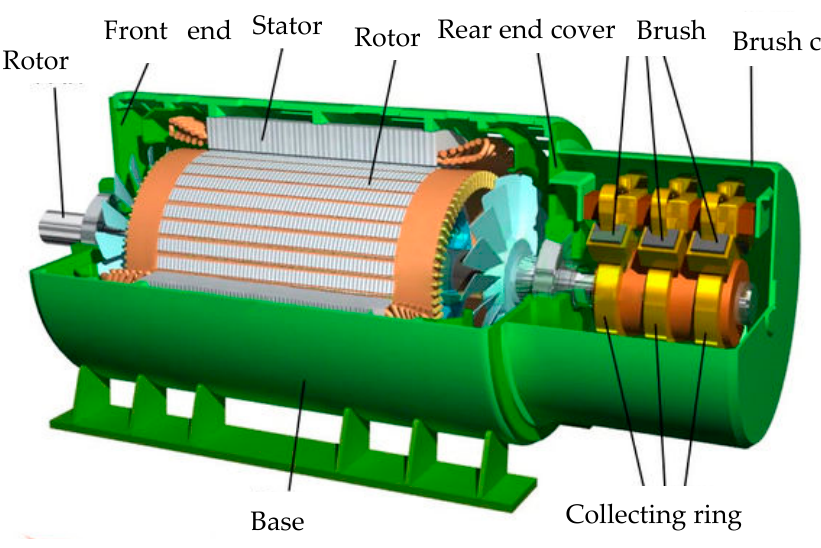
Figure 7. Typical WT generator structure.